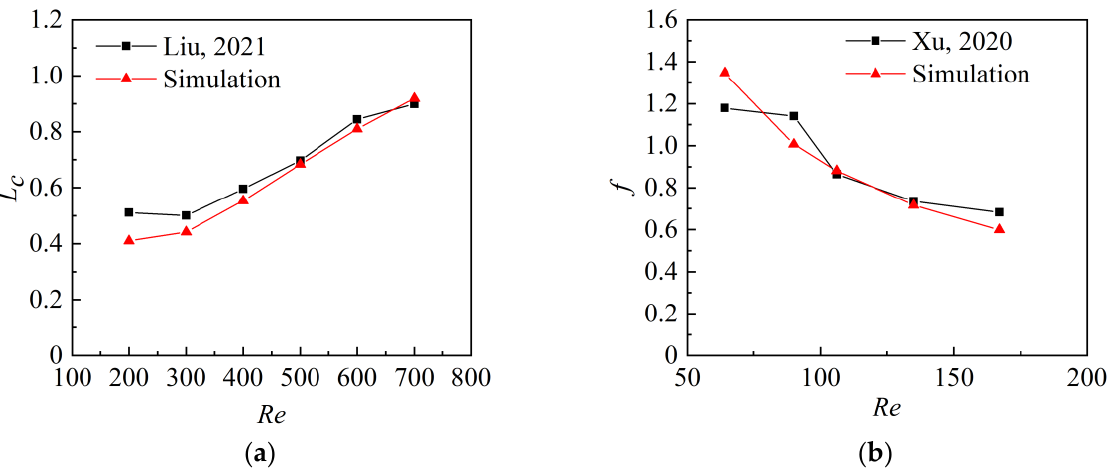
Figure 3. Comparison of experimental results and simulation results ( a ) average dimensionless location of vortex center[34]; ( b ) friction factor[35].